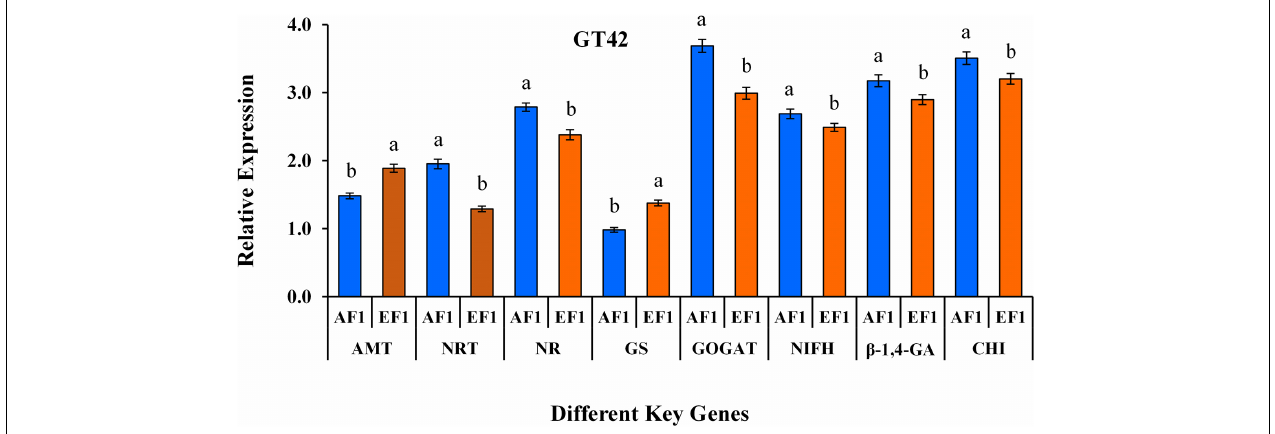
FIGURE 8 | qRT-PCR study of aminomethyl transferase - AMT , nitrate transporter - NRT , nitrate reductases- NR , glutamate synthase- GS , glutamine synthetase- GOGAT , nitrogen fixation- nifH , endo-glucanase- β -1,4-GA, and chitinase- CHI genes in root tissue of sugarcane variety (GT42) inoculated with P. cypripedii AF1 and K. arachidis EF1 strains. The GAPDH expression level was used to standardize the data. All data points are viewed as the mean ± SE ( n = 3). Different letters specify significant differences among the treatments at p ≤ 0.05.